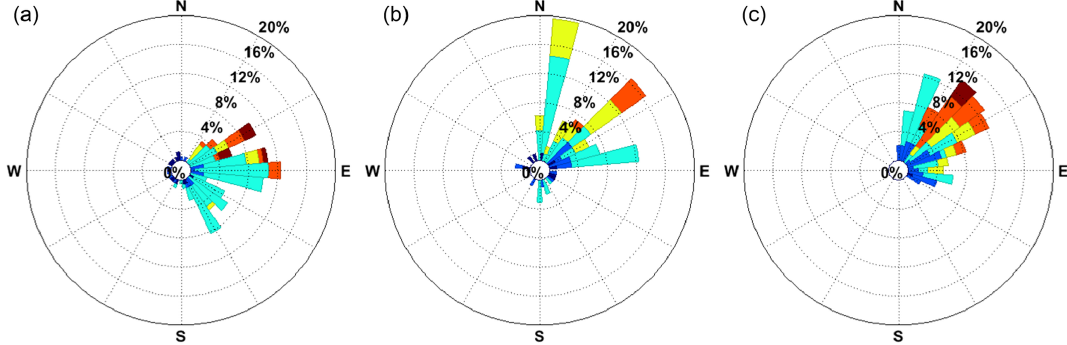
Figure 5. Wind roses compiling ERA5 data for 7 (a) , 4 (b) , and 6 (c) days respectively for the 2007, 2009, and 2017 pollution episodes. The colour code is the same as in Fig. 4.